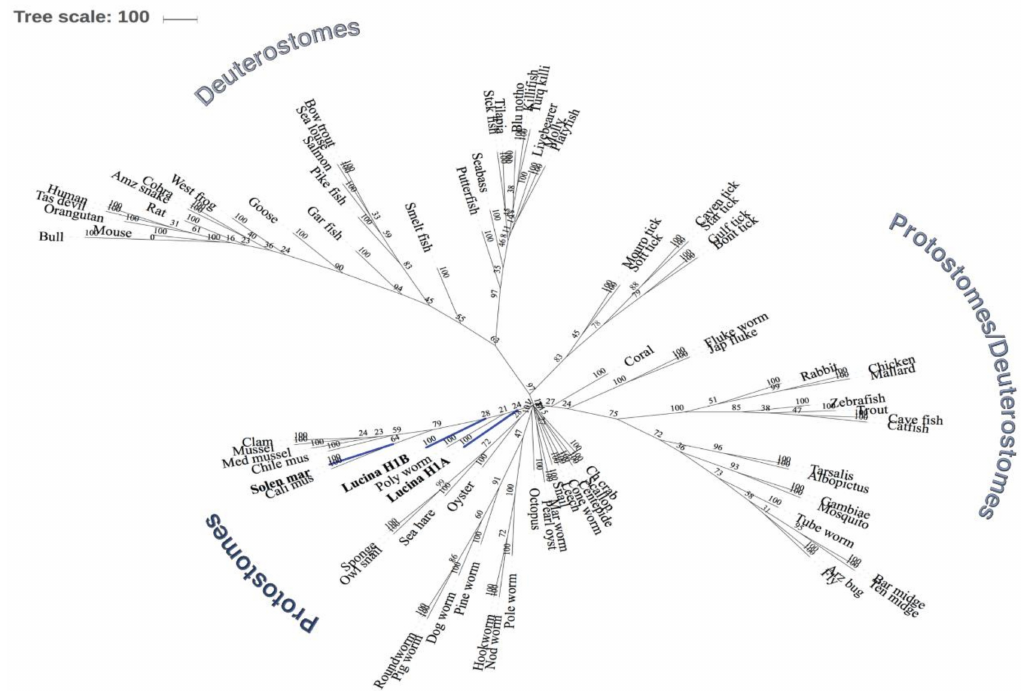
Figure 10. Phylogenetic Analysis between Histones H1 proteins of Lucina pectinata and Histone H1 protein from various species. An unrooted maximum likelihood (ProML) phylogenetic gene tree model was built from the CLUSTALW alignment. Numbers for nodes (interior of branches) represent bootstrap values based on 100 replicates. The L. pectinata query sequences (H1_A and H1_B) and the S. marginatus H1 protein sequence are shaded in blue. The legend provided represents the subtaxons of protostomes and